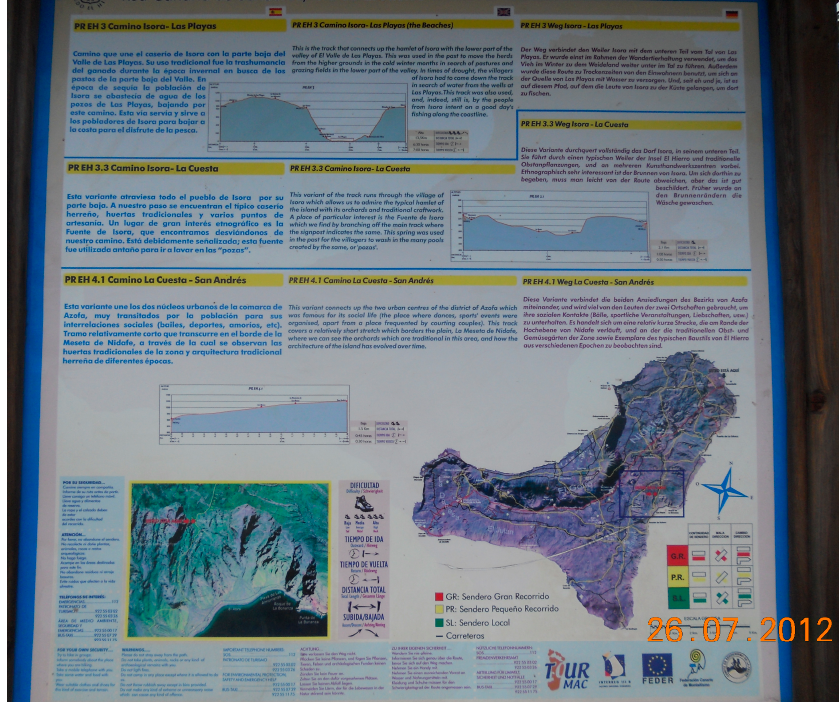
Figure 3. El Hierro UNESCO Biosphere Reserve with landform and technical documentation, Photo: G. Jastrz ę bska.